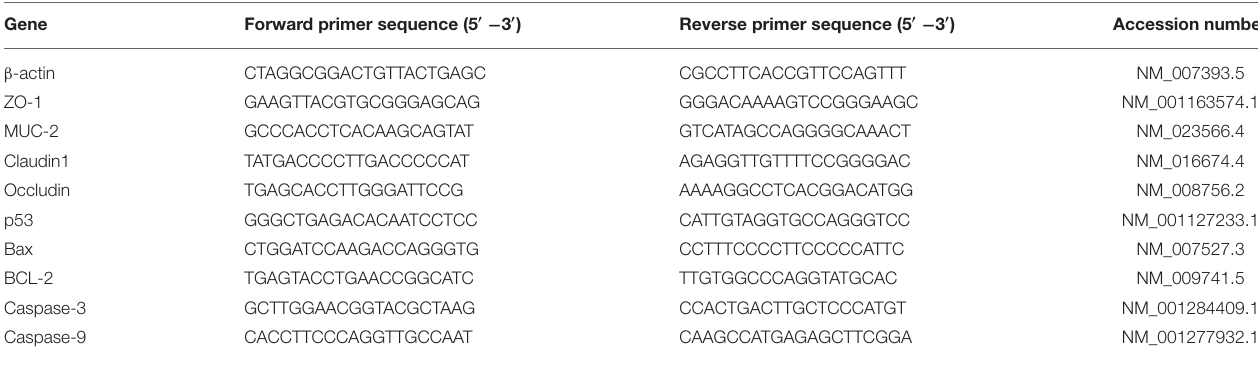
TABLE 1 | Primer sequences for